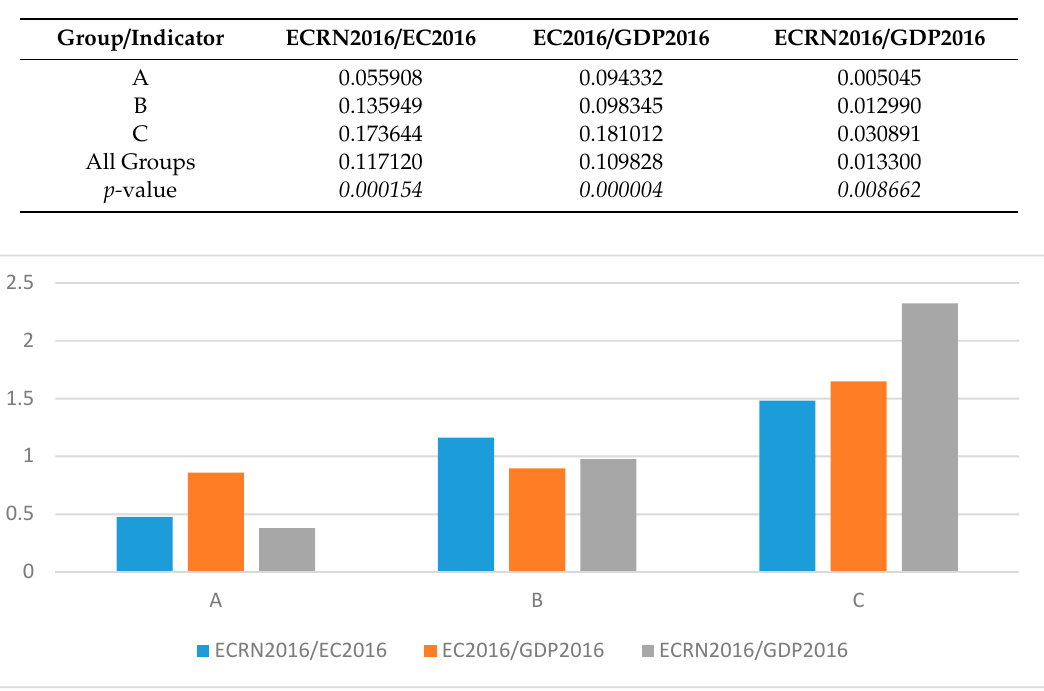
Figure 15. Energy sources in the countries of group C in 2016. The structure of the electrical capacity divided into wind and solar power plants (renewable energy sources) and sum of non-renewable energy sources and hydro power is presented for groups A and B in Figure 16 Error! Reference source not found. and Figure 17 Error! Reference source not found. , respectively.